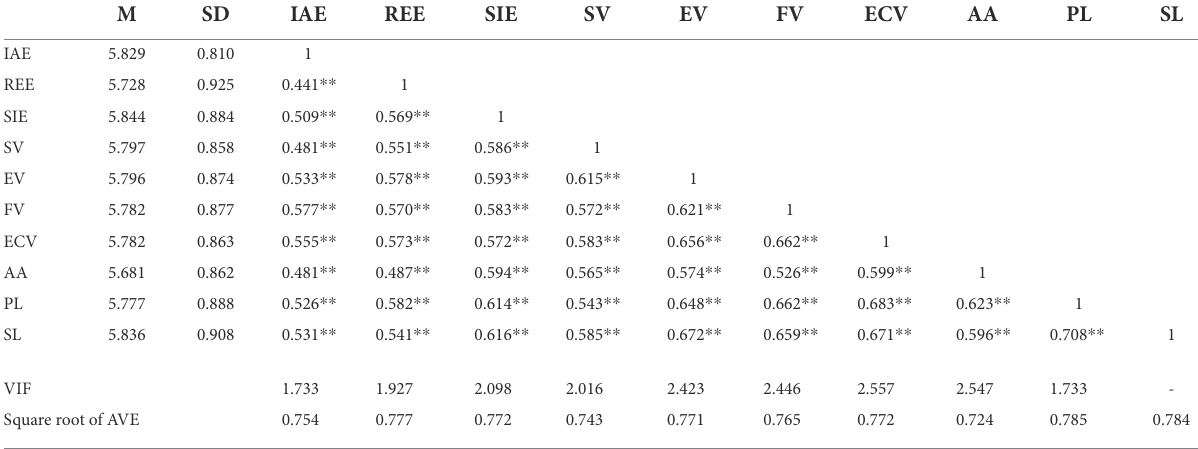
TABLE 4 Mean, standard deviation, Pearson correlation matrix, and variance inflation factors of